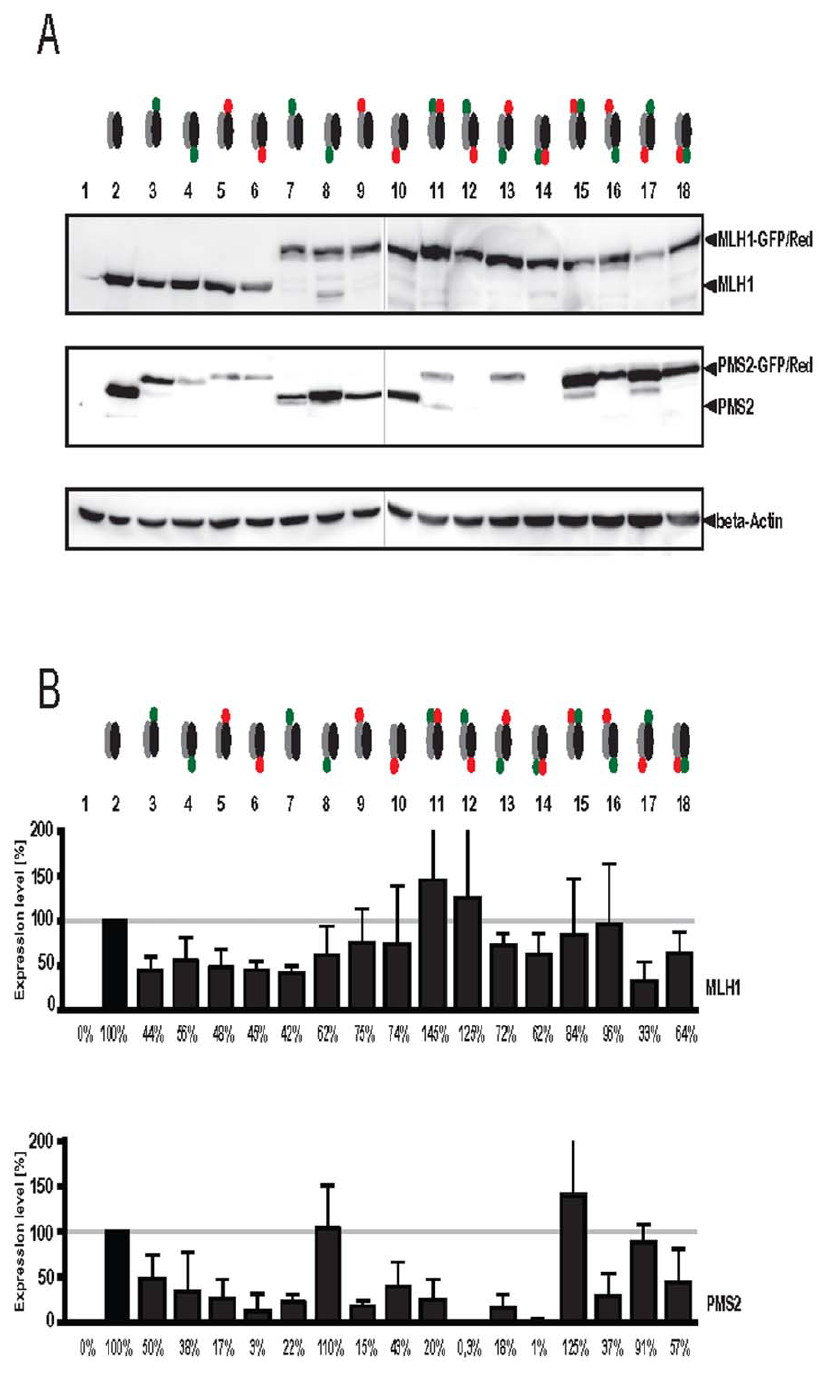
Figure 2. Influence of fluorescent labeling of MutL a on protein expression levels. To analyze the effect of fluorescent dyes on protein expression levels, HEK293T cells were transiently cotransfected with different MutL a constructs (see below) and (A) Western blot analysis was carried out after 48 h using anti-MLH1 or anti-PMS2, respectively, controlled by b -actin detection. (B) Amounts of expressed proteins were assessed by measuring the signal intensities of protein bands with Multi Gauge V3.2 software. Graphs indicate the results (mean 6 S.D.) of at least four independent experiments in which the proportion of protein expression using an unbiased method were presented. 1: negative control (untransfected). 2: MLH1/PMS2 unlabeled; 3: MLH1/PMS2-GFP-N; 4: MLH1/PMS2-GFP-C; 5: MLH1/PMS2-Red-N; 6: MLH1/PMS2-Red-C; 7: MLH1-GFP-N/ PMS2; 8: MLH1-GFP-C/PMS2; 9: MLH1-Red-N/PMS2; 10: MLH1-Red-C/PMS2; 11: MLH1-GFP-N/PMS2-Red-N; 12: MLH1-GFP-N/PMS2-Red-C; 13: MLH1- GFP-C/PMS2-Red-N; 14: MLH1-GFP-C/PMS2-Red-C; 15: MLH1-Red-N/PMS2-GFP-N; 16: MLH1-Red-N/PMS2-GFP-C; 17: MLH1-Red-C/PMS2-GFP-N; 18: MLH1-Red-C/PMS2-GFP-C. Symbols see Figure 1.